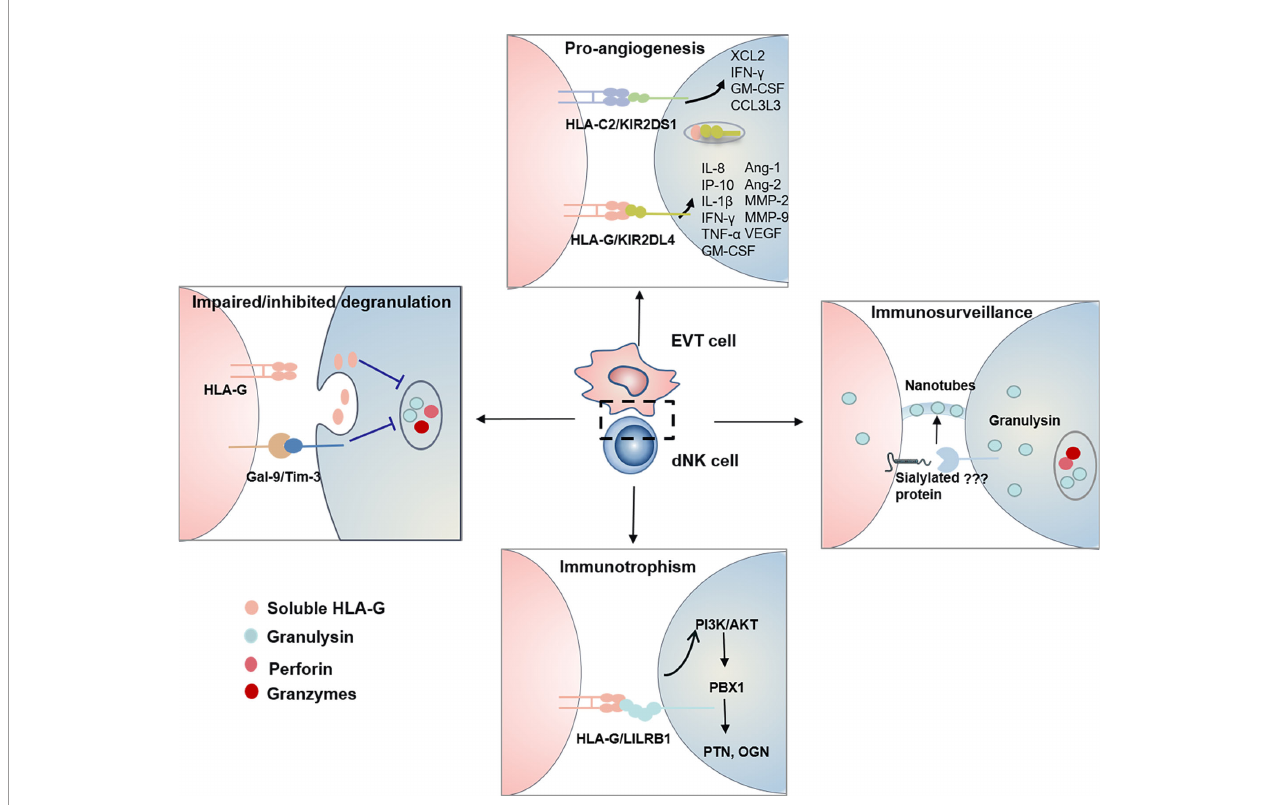
FIGURE 2 | The functional dialogue between dNK cells and EVT cells at the maternal-fetal interface. HLA-G Cycle and Gal-9/Tim-3 signal inhibit/impair degranulation process and control the cytotoxicity of dNK Cells. Human dNK cells selectively transfer GNLY but not granzymes via nanotubes to EVT cells. Transferred GNLY kills intracellular bacteria without killing the EVT cells. Sialylated protein on the target cell promotes nanotube formation, while its receptor on dNK cells need further research. KIR/HLA allorecognition system (KIR2DS1-HLA-C2 and KIR2DL4-HLA-G) drives EVT cells invasion and uterine artery remodeling via synthesizing a series of soluble factors. HLA-G-LILRB1 signal activates the PI3K-AKT pathway and drives the expression of transcription factor PBX1. Furthermore, PBX1 upregulates the transcription of the GPF including PTN and OGN and promotes fetal development.